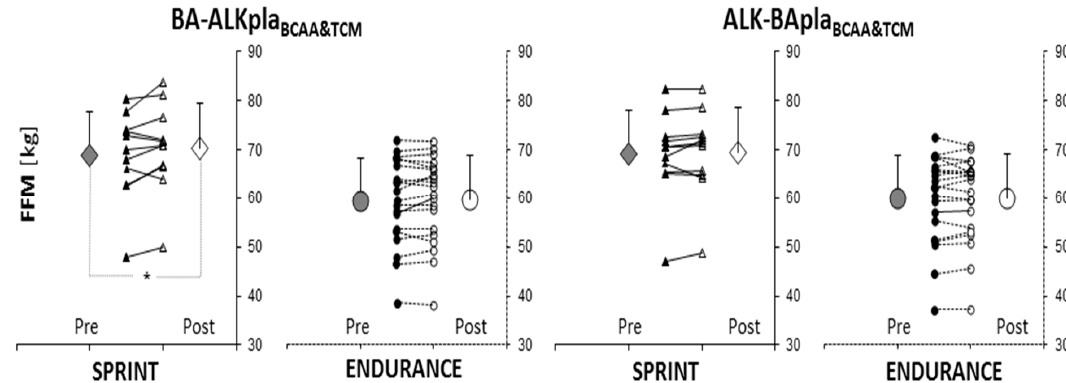
Figure 2. Changes in fat-free mass before and after supplementation. Abbreviations: ALK—Alkaline agents, BA—Beta-Alanine Carno Rush, BCAA—branched-chain amino acids, FFM—fat-free mass, pla–placebo, and TCM—creatine malate. *: significant difference between “Pre” and “Post” values ( p < 0.01) .